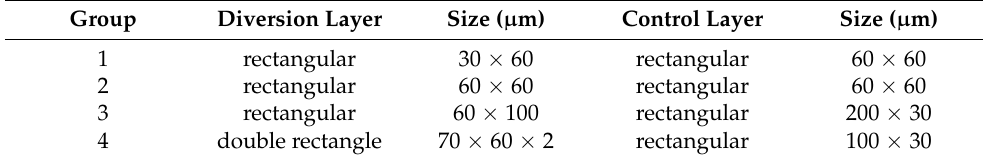
Table 1. Structure sizes of solid-state ON – OFF switch.